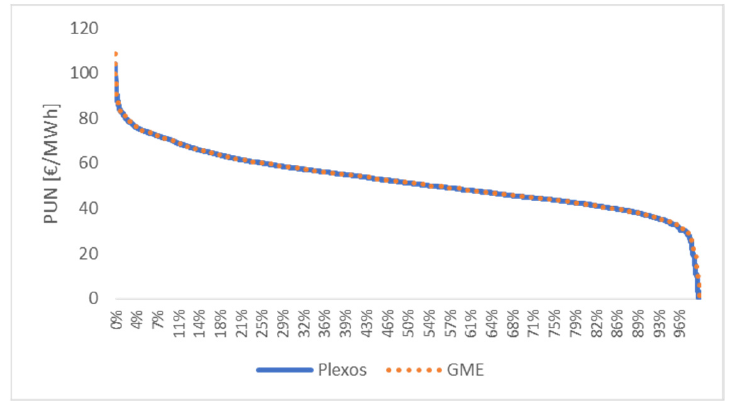
Figure 2. PUN duration curve of Plexos base simulation and GME simulation.